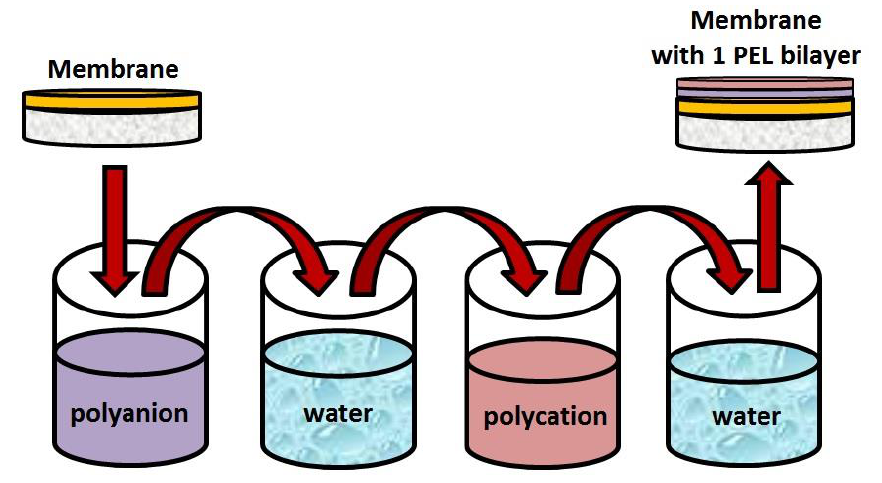
Figure 1. Layer-by-layer (Lbl) deposition scheme.